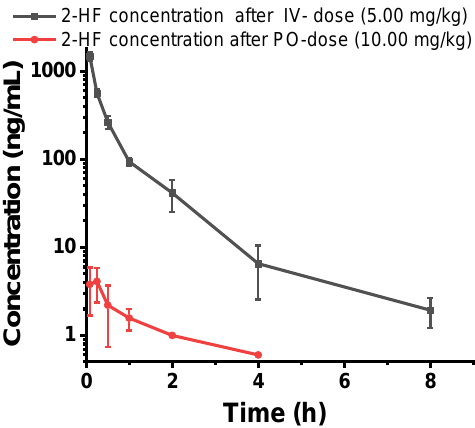
Figure 7. Plasma concentration vs. time profile of 2HF in rats. Mean plasma concentration vs. time profile of 2HF following intravenous and oral administration of 2HF at 5 mg/kg and 10 mg/kg, respectively, to male SD rats ( n = 3).